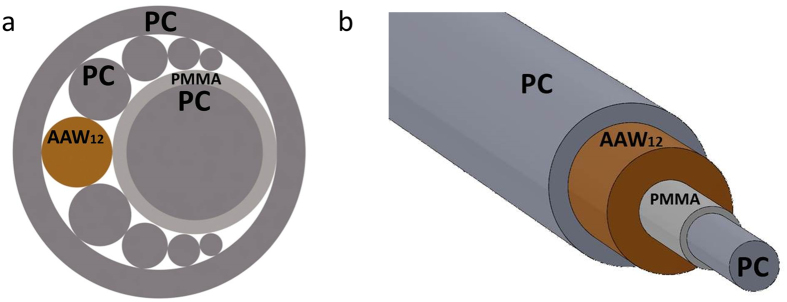
Preform cross-section illustrations of: (a) the two circular-core fiber, and (b) the ring-core fiber. Material labels: PC: polycarbonate, PMMA: poly(methyl methacrylate), AAW12: 45AgI-43AgPO3-12WO3 glass (mol%).